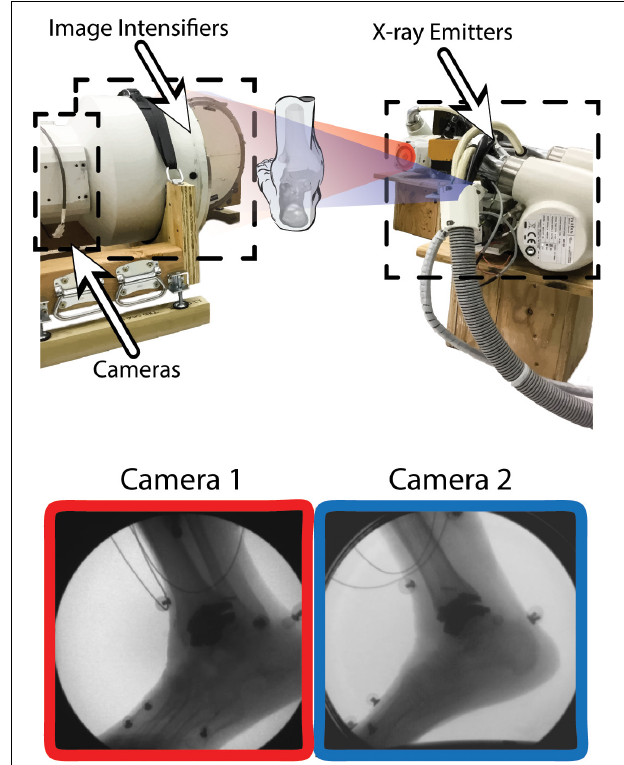
FIGURE 2 | Dual fluoroscopy (DF) system setup for overground walking with two X-ray emitters and two image intensifiers with high-speed cameras oriented ≈ 90 degrees from one another. Two synchronized DF views (Camera 1 and 2) are shown during overground walking toward the toe-off phase of gait. Wires from electromyography sensors can be seen in the DF